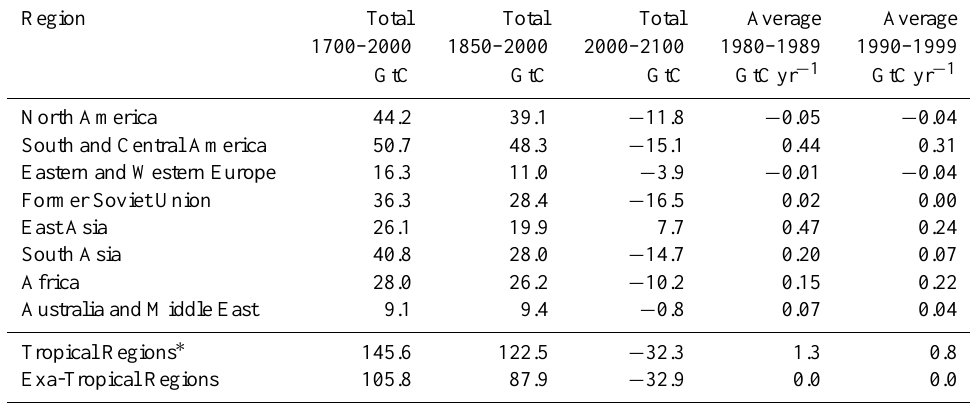
Table 4. Net land-use change emissions and uptake (GtC) by region.